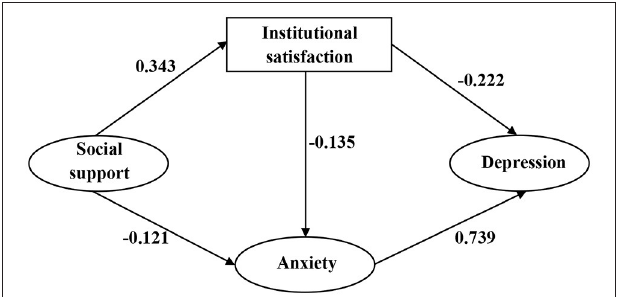
FIGURE 2 | Structural analysis of social support, institutional satisfaction, anxiety and depression. All coefficients are significant ( P < 0.05).